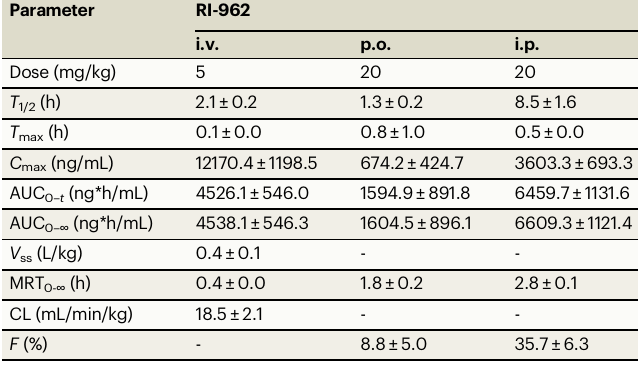
Fig. 7 | RI-962 protected cells from TSZ-induced necroptosis. a – d Dose – responsecurvesofRI-962( n =3)andGSK3145095( n =2)inTSZ-induced HT29, L929, J774A.1, and U937 cell necroptosis models. Necroptosis of HT29, J774A.1 and U937 cells was induced by TNF α (10ng/mL), Smac-mimetic (100nM), and Z-VAD-FMK (40 μ M). Necroptosis of L929 cells was induced by TNF α